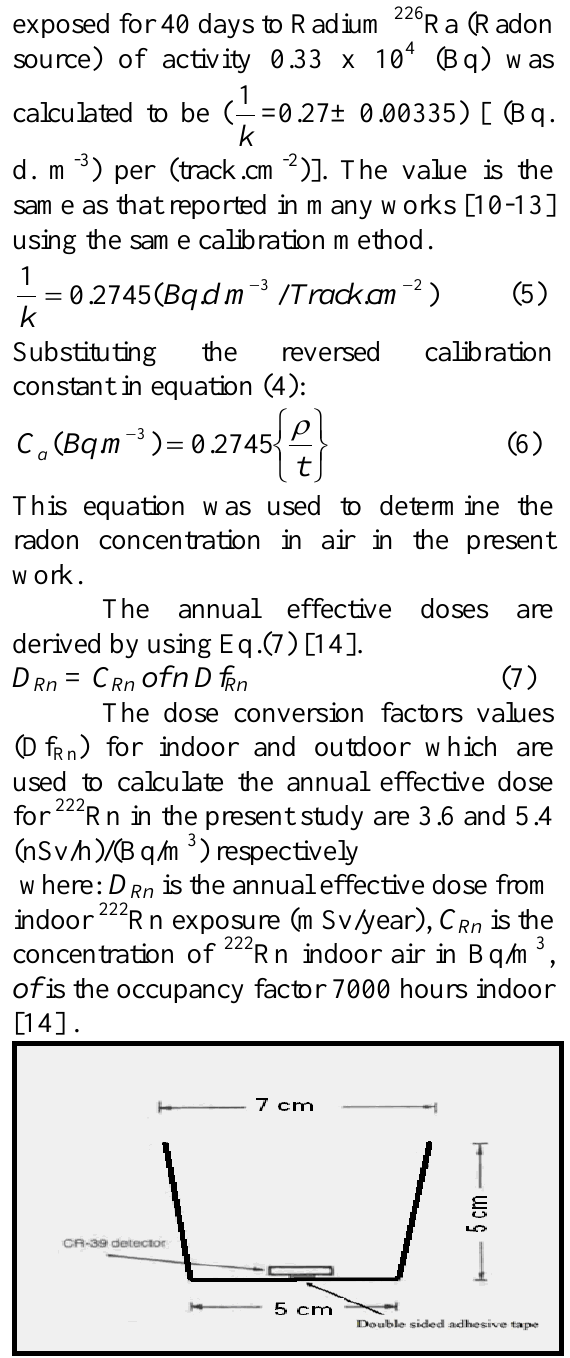
Fig.1: A schematic diagram of the sealed-cup technique.